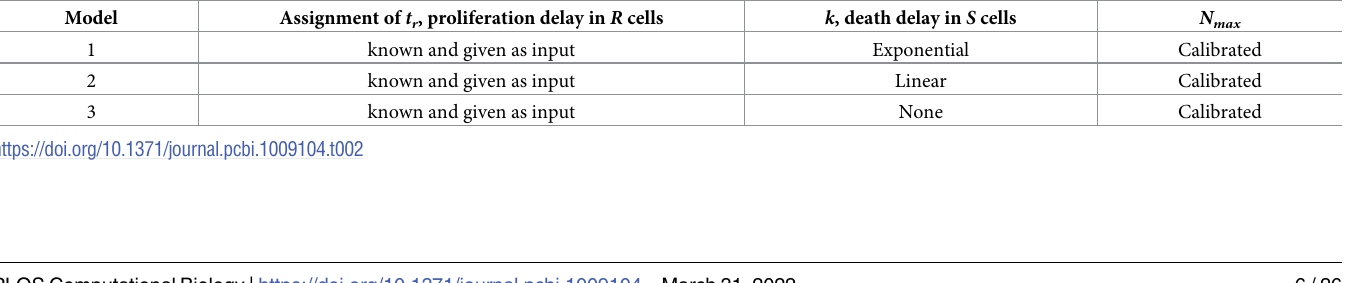
Table 2. Summary of model assumptions in models selected for further analysis.